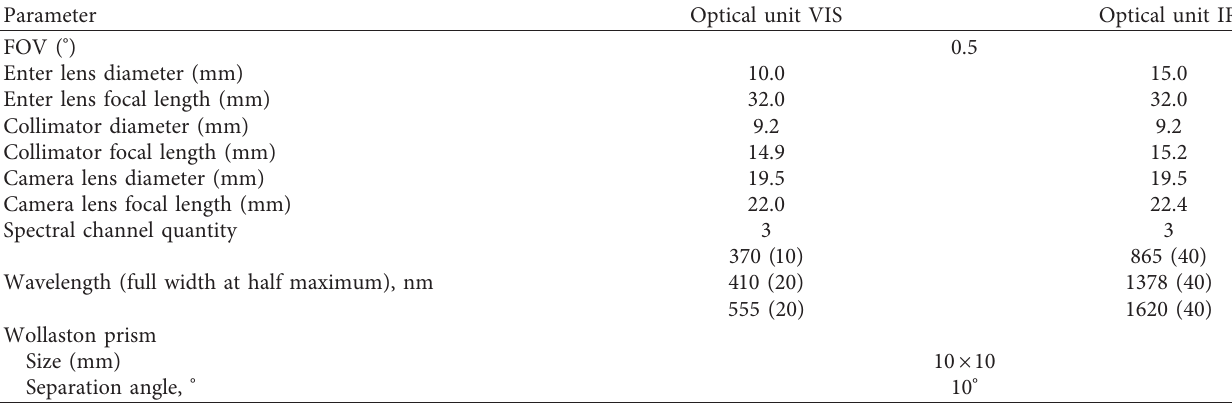
Table 1: Main parameters of the ScanPol’s PSA optical system.